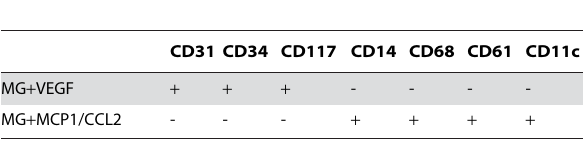
Table 1. Cells recruited by VEGF or by MCP-1 express different